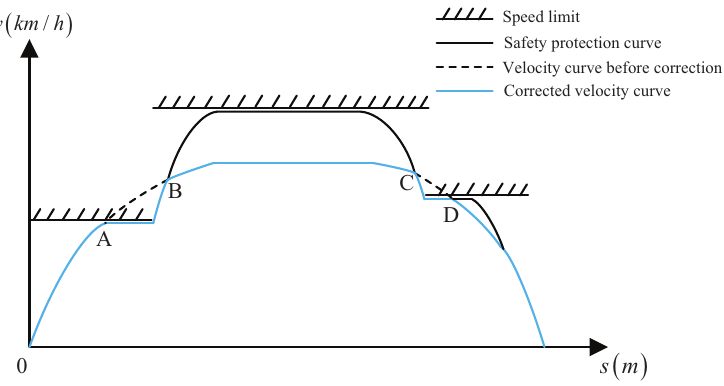
Figure 2. The safety protection curve of the whole operating